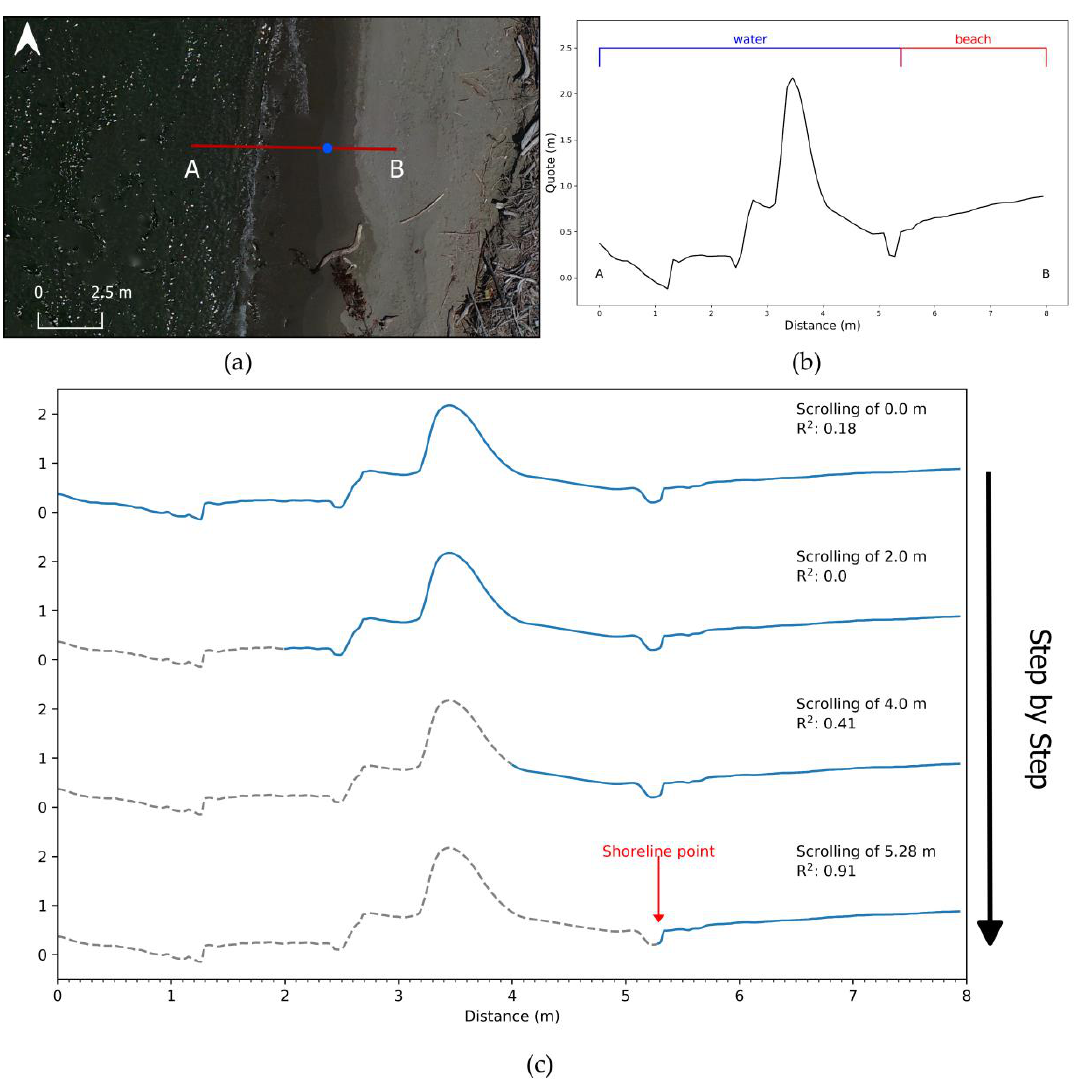
Figure 3. Description of shoreline identification from the Unmanned Aerial Vehicle (UAV) orthomosaic and Digital Elevation Model (DEM). ( a ) The location is a typical transect starting from sea and ending on the beach (red line). The blue point represents the local attribution of the shoreline by an algorithm; ( b ) profile on DEM from SfM of the investigated transect; ( c ) four illustrative steps of the algorithm to find the shoreline point. R 2 is calculated only on the part of the profile coloured in blue. The grey dashed line represents the progressive part of the profile discarded by the algorithm.